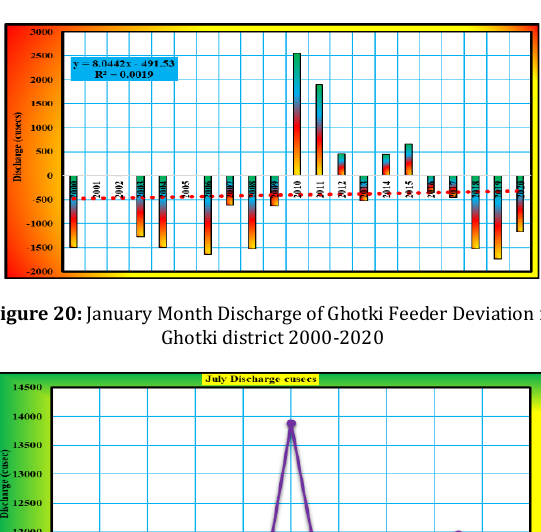
Figure 19: Represents January Month Discharge Trend Line of Ghotki Feeder Canal 2000-2020